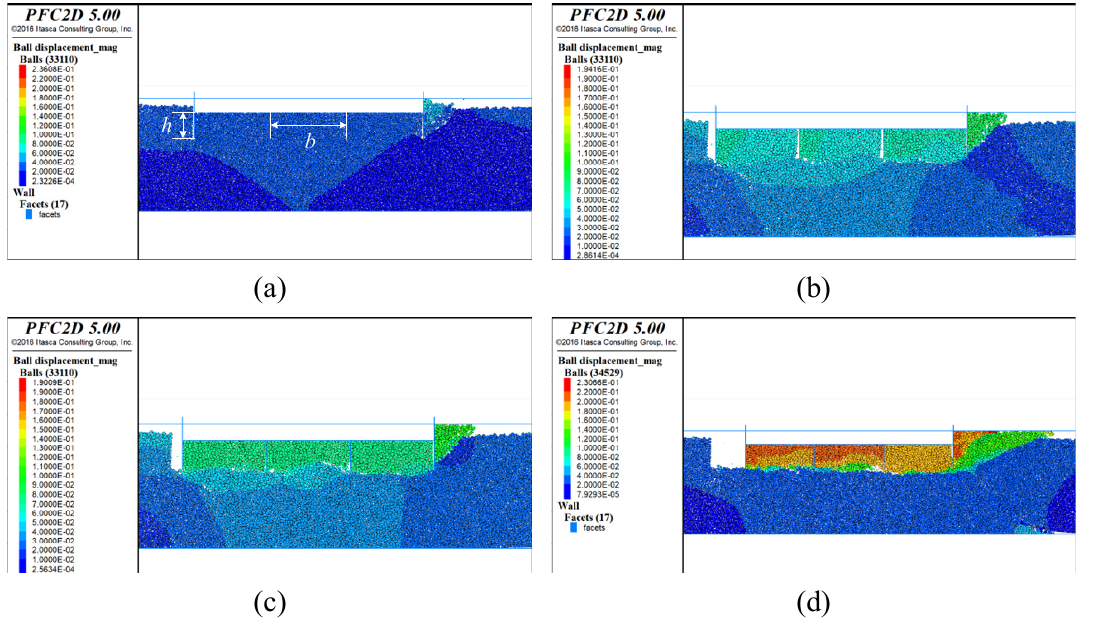
Figure 6. DEM track shear model: ( a ) j = 1 mm; ( b ) j = 3 mm; ( c ) j = 5 mm; ( d ) j = 15 mm.